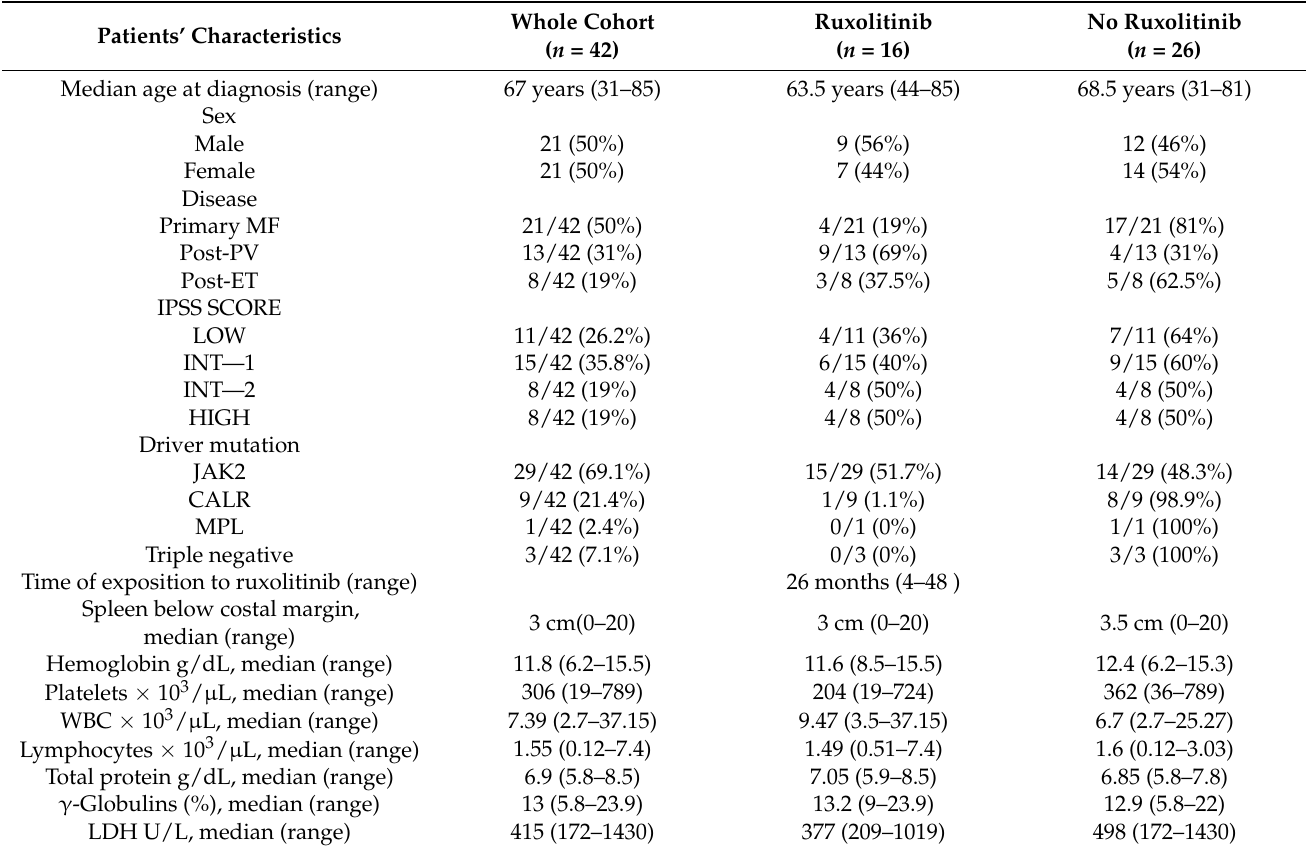
Table 1. Clinical characteristics of MF patients included in the study. PV = polycythemia vera; ET= essential thrombo-